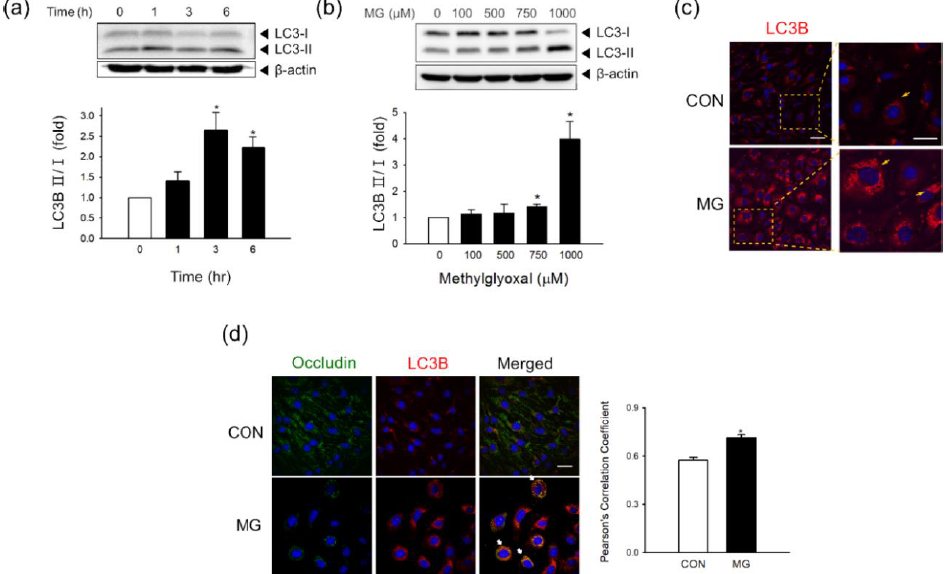
Figure 5. Autophagy activity and co-localization of occludin with LC3B 24 h after MG exposure in brain ECs. ( a , b ) The protein levels of LC3B-I/II were determined ( a ) at 0, 1, 3, or 6 h after treatment with 1000 μM MG ( n = 3) or ( b ) at 24 h after treatment with 0 –1000 μM MG by western blotting ( n = 4). ( c ) MG-exposed bEnd.3 cells were stained with an antibody against LC3B and visualized by confocal microscopy. Scale bar: 50 μm. ( n = 4) ( d ) Co-localization of occludin with LC3B was analyzed after MG exposure using confocal microscopy. Scale bar: 20 μm. Pearson’s correlation coefficients were calculated from three independent experiments ( n = 3). Representative images are shown. Data are presented as mean ± SEM. * p < 0.05 vs. control (CON). Antioxidants 2020 , 9 , x FOR PEER REVIEW